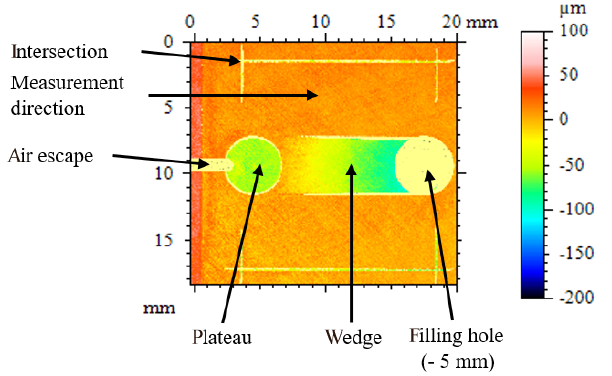
Figure 8. Topography of the thin-film thickness standard measured with the Alicona InfiniteFocus without lubricant and a cover plate.